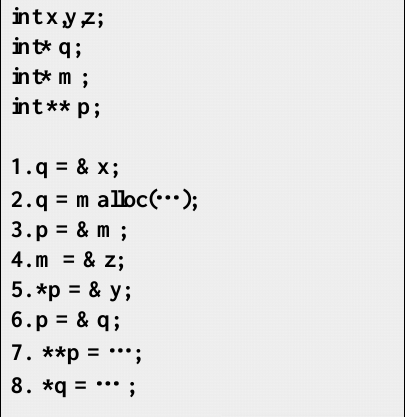
Fig.3. Multi-pointer